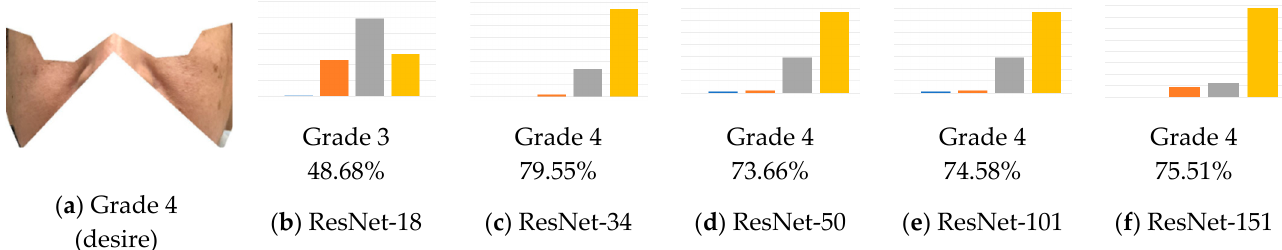
Figure 10. Example and training results of Grade 3 cheek wrinkles (wrongly classified grades are underlined).